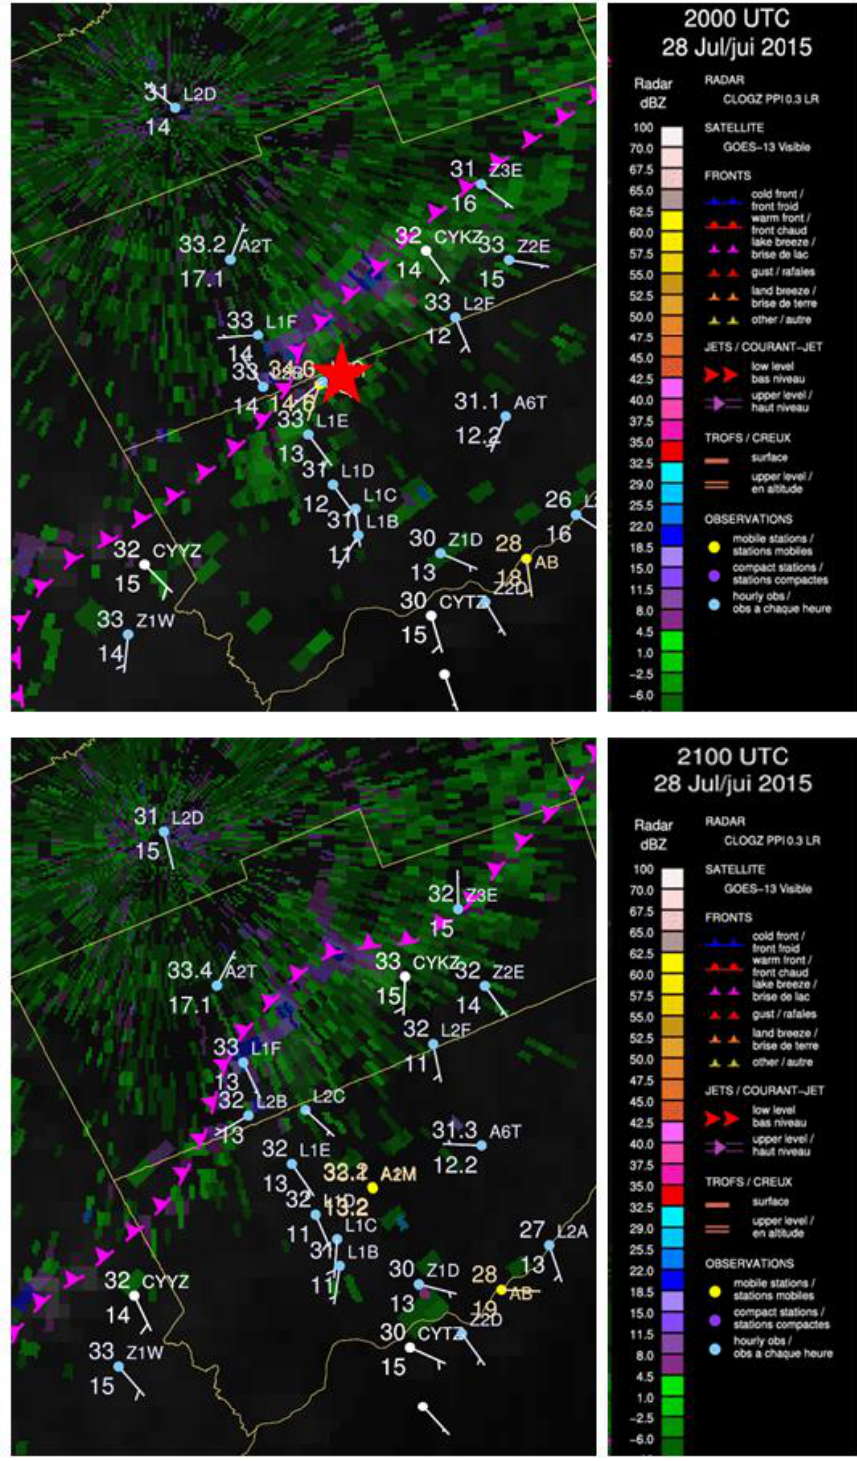
Figure 16. Mesoscale meteorological analysis at 20:00 UTC and 21:00 UTC 28 July 2015. The purple lines are the measurement-derived lake-breeze fronts. The wind data at stations is for a 10-m height. The colour scale is radar reflectivity. The red star in the first panel is the location of the ECCC mobile AQ laboratory (CRUISER) at 20:00 UTC when it measured 90 ppbv O 3 .